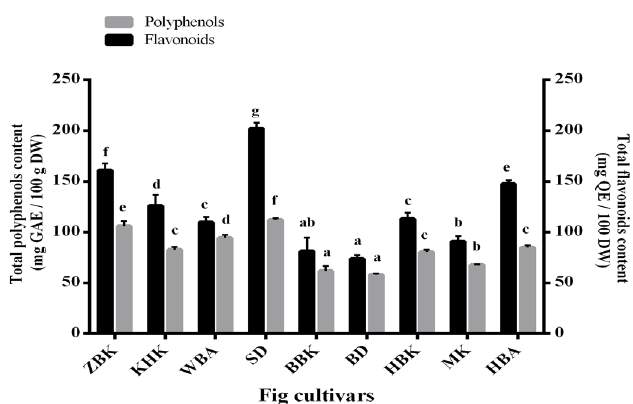
Fig. 2: Contents of total phenolics (mg GAE/100 g DM) and flavonoids (mg QE/100 g DW) in nine cultivars of dry figs. Data are displayed as mean ± standard deviation of three replications for each cultivar. Letters above columns represent the groups given by Duncan test (α = 0.05) in arising order. Different letters indicate significant differ- ence at P <